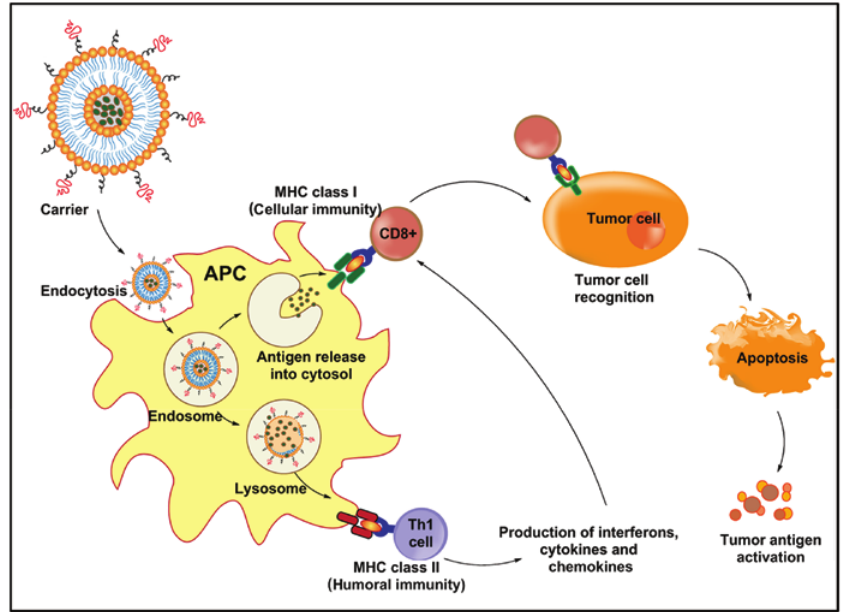
Figure 2: Schematic representation of immunotherapy mediated by engineered